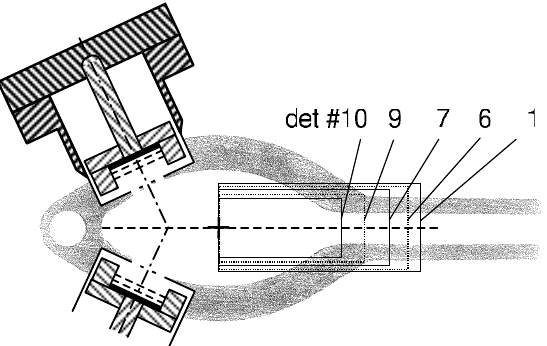
FIG. 3. Schematic of APS planar retarding field analyzer (RFA). The collector is graphite coated to lower (cid:3) and biased at (cid:6) 45 V to enhance the collection efficiency. The grounded, outer grid is mounted behind a slotted vacuum penetration to shield the RFA from beam-induced rf noise. The penetration slot area is approximately 1 : 25 cm 2 , and approximate distances between the chamber wall (1.6 mm thick), grids, and collector are indicated.